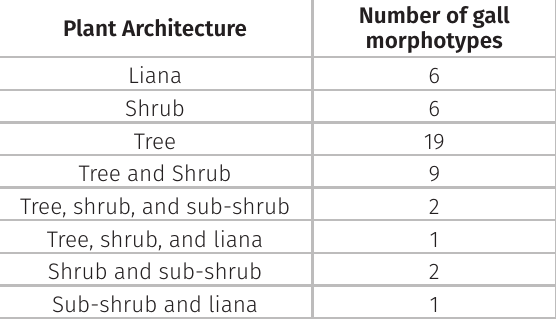
Table VII. Richness of gall morphotypes per plant architecture in the Natural Heritage Private Reserve of Serra Negra do Funil (Minas Gerais, Brazil). Plant